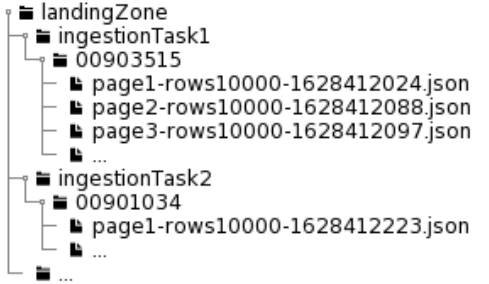
Figure 4. Primarily ingested IoT data files storage